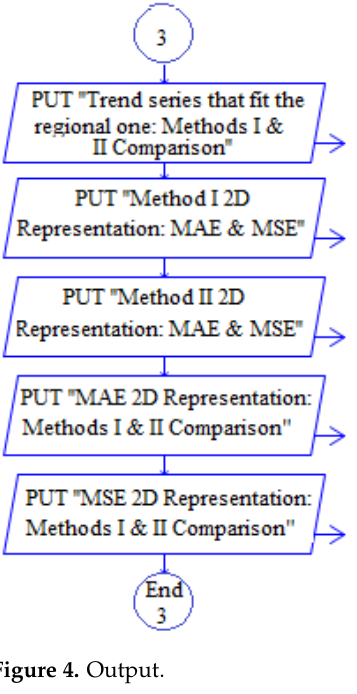
Figure 3. Logical scheme for Method I (the left-hand side) and Method II (the right-hand side).